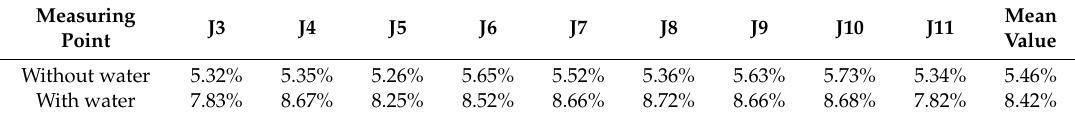
Table 8. Damping ratio of the first-order mode of the